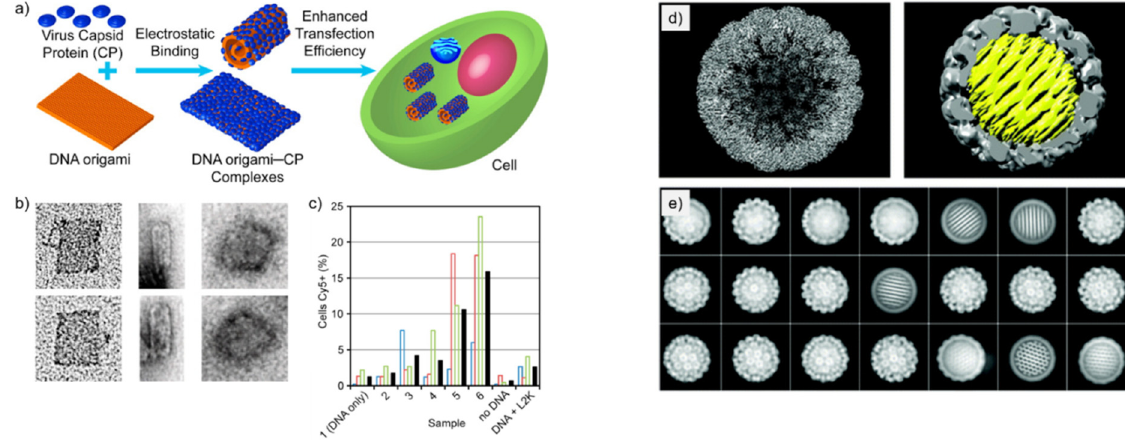
Figure 2. DNA origami encapsulation inside virus capsid proteins. ( a ) Schematic illustration of the formation of DNA- origami-CCMV CP complexes via electrostatic interactions and enhanced transfection to cells [40]. ( b ) TEM images of DNA origami-CP complexes with various γ values (from left to right: γ = 0, γ = 0.08, γ = 0.64). ( c ) Quantification of DNA origami–CP positive cells with HCS microscopy ( γ increases gradually from samples 1 to 6). Colored open bars indicate measurements from individual samples; black-filled bars are calculated mean values of the triplicate samples. ( d ) Reconstructed SV40 particles: left, empty capsid; right, SV40 capsid (gray) encapsulated spherical DNA origami (yellow) of 35 diameter [44]. ( e ) Class averaged particles images show both the empty capsids and the encapsulated DNA origami in different orientations. ( a – c ) reproduced with permission from [40]. Copyright American Chemical Society, 2014. ( d , e ) reproduced with permission from [44]. Copyright Royal Society of Chemistry,